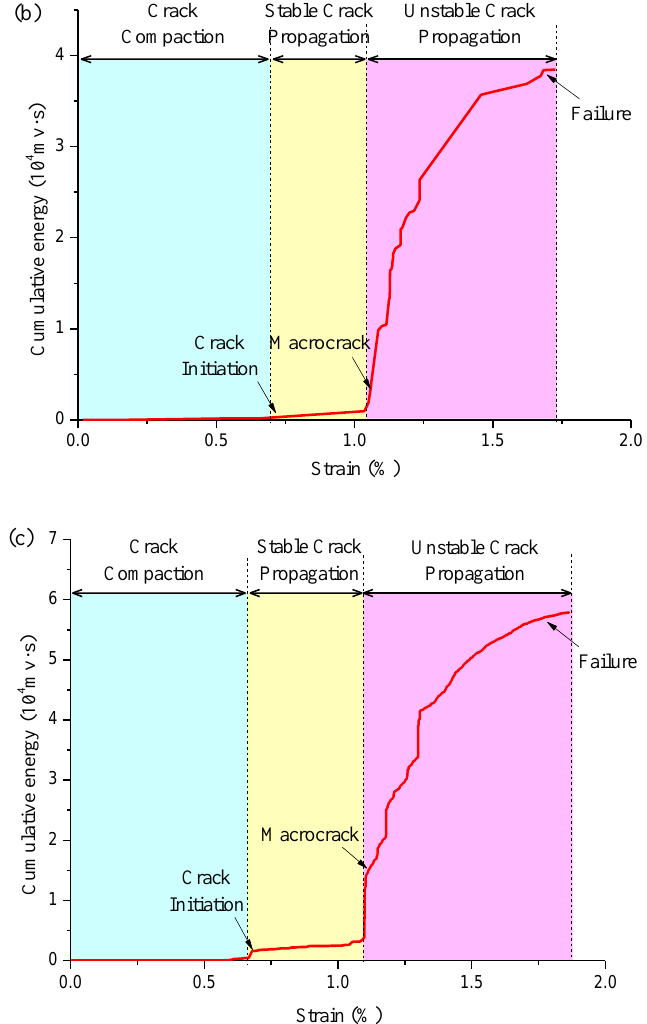
Figure 10. Representative curves of cumulative AE energy with the axial strain of coal specimens under different mining paths. ( a ) Sample C-1; ( b ) Sample C-2; ( c ) Sample